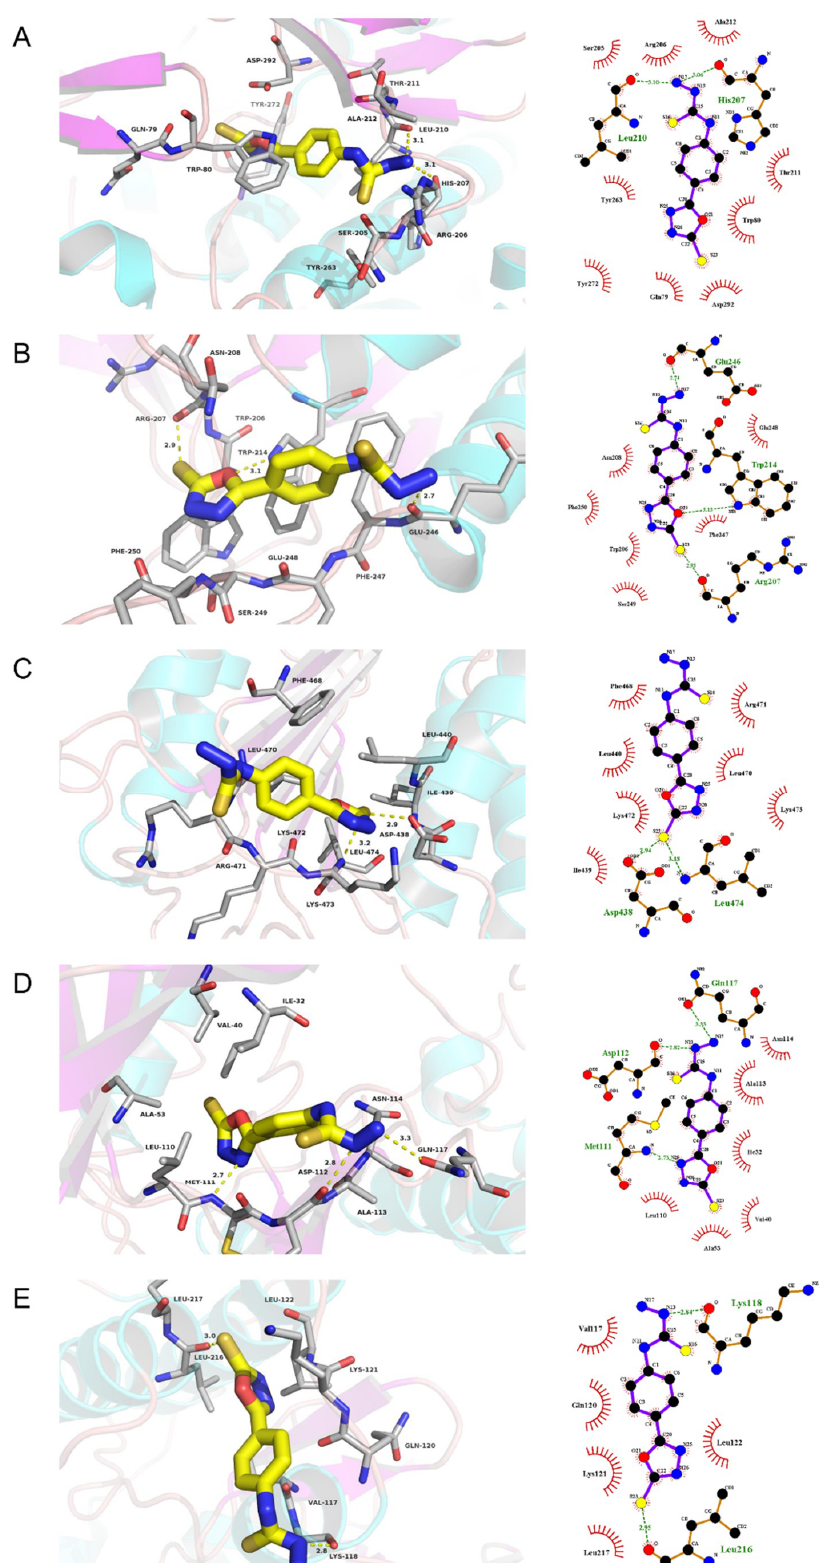
Figure 5. Molecular models of the binding of stemazole to the predicted targets ( A ) AKT1, ( B ) CASP3, ( C ) CASP8, ( D ) MAPK8, and ( E ) MAPK14 shown as 3D diagrams and 2D diagrams.